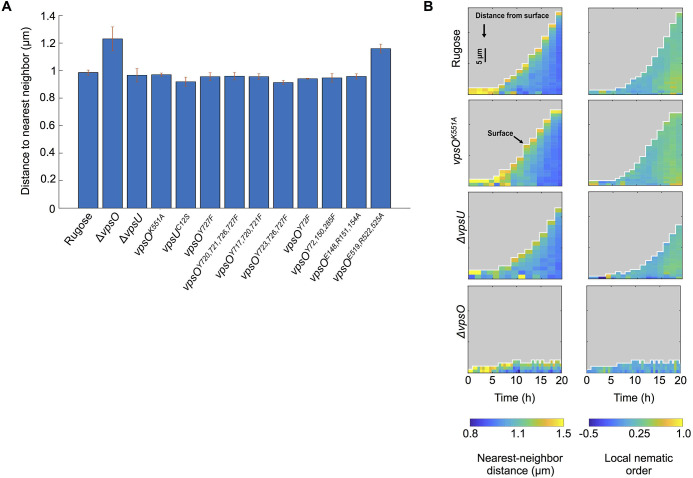
VPS influence biofilm architecture at single-cell level.(A) Nearest-neighbor distances in the context of distance (15 μm) from the center of biofilms under flow conditions for 21 hours; n = 3. (B) Nearest-neighbor distance and nematic order average analysis between cells in the context of time and height of flow cell biofilms of rugose, vpsOK551A, ΔvpsU, and ΔvpsO, n = 3.